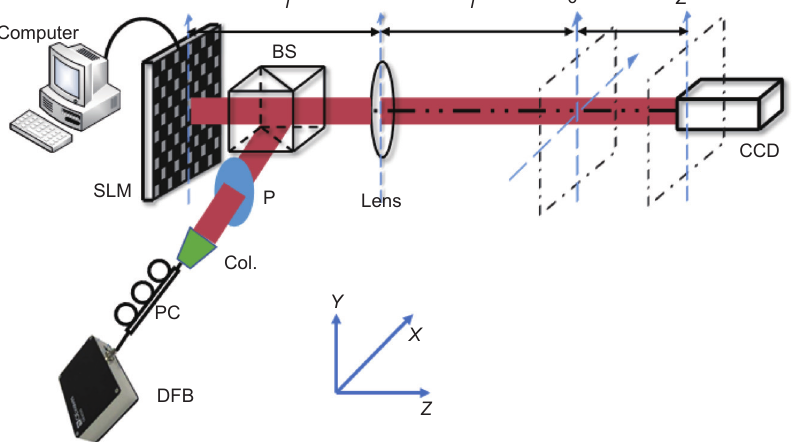
Fig. 2 | Experimental setup for the optical field rotation of 2D self-accelerating beams. DFB: distributed feedback laser; Col.: collimator; PC: polarizer controller; P: polarizer; BS: beam splitter; SLM: spatial light